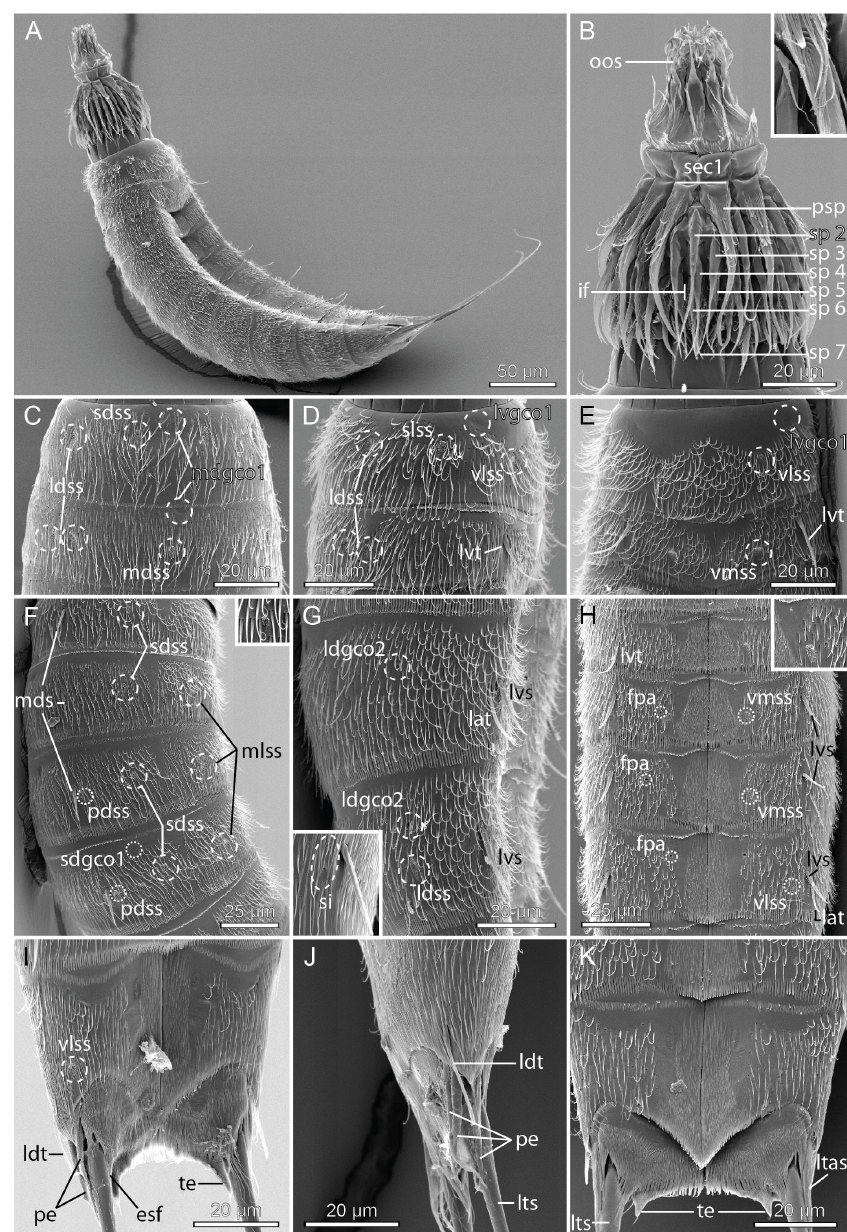
Fig. 4. Scanning electron micrographs showing overviews and details of Echinoderes dujardinii Claparède, 1863. A–B, D, G–H, K . ♀ ( MVS, personal reference collection). C, E–F, I–J . ♂ ( MVS, personal reference collection). A . Lateroventral overview. B . Head with mouth cone and introvert, ventral view; inset shows detail of primary spinoscalid fringes attaching along a longitudinal line, and the median basal sheath spike of the Ring 03 spinoscalid. C . Segments 1 to 2, dorsal view. D . Segments 1 to 2, lateral view. E . Segments 1 to 2, ventral view. F . Segments 4 to 7, subdorsal view; inset shows the minute midlateral sensory spot on segment 4. G . Segments 8 to 9, lateral view; inset shows detail of sieve plate and lateroventral spine of segment 9. H . Segments 5 to 8, ventral view, showing female sexual dimorphism; inset shows detail of glandular cell outlet type 1, sensory spot and female papillae on left sternal plate of segment 6. I . Segments 10 to 11 ventrolateral view, showing male sexual dimorphism. J . Segments 10 to 11 lateral view, showing male sexual dimorphism. K . Segments 10 to 11 ventral view, showing female sexual